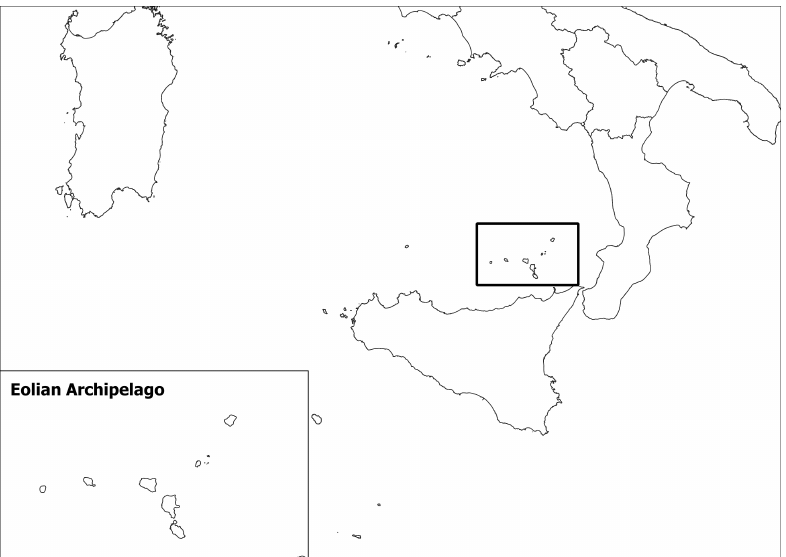
Figure 23. Eolian